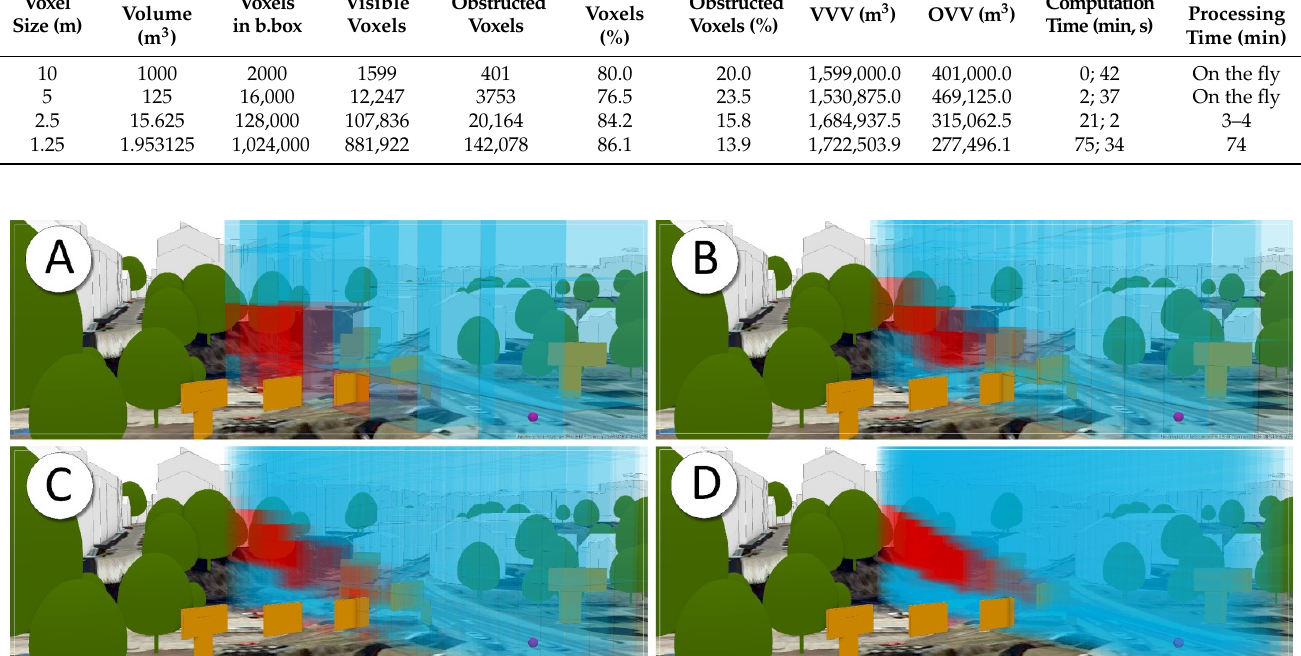
Figure 8. The effect of voxel sizes on the VVV (blue) and OVV (red) measurement accuracy: ( A ) 10 m voxels, ( B ) 5 m voxels, ( C ) 2.5 m voxels, ( D ) 1.25 m voxels. The voxel size has been thinned by 0.1 m to highlight the edges.